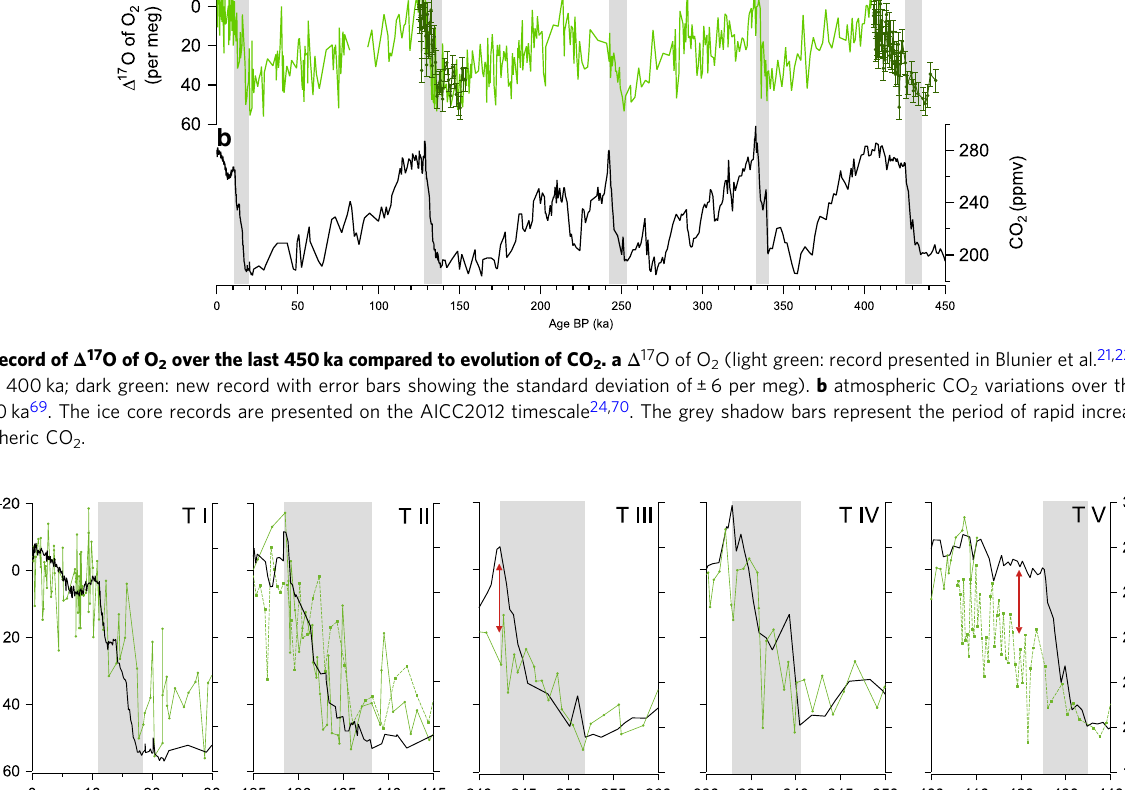
Fig. 2): the fi rst case at the very end of Termination III, between